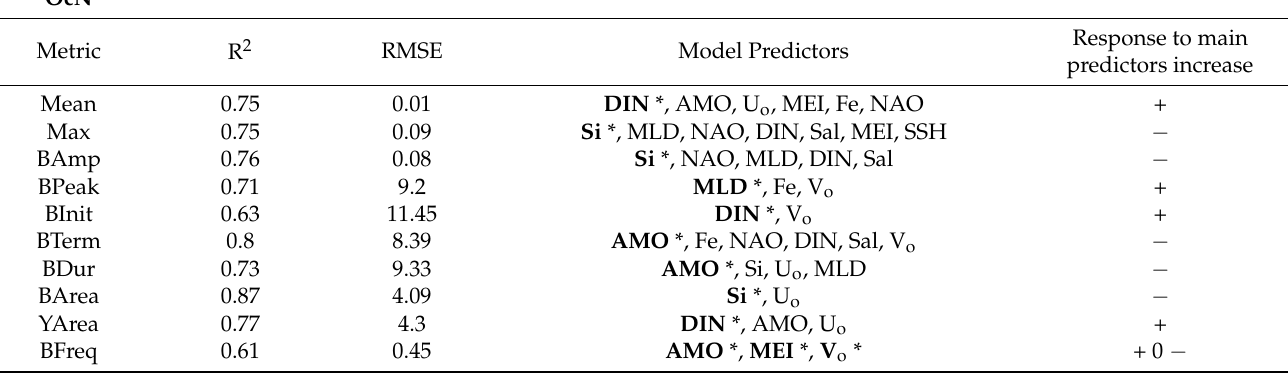
Table 4. Random forest models result for each phenoregion. For each phenology metric, the coefficient of determination (R 2 ), the root-mean-squared error (RMSE) and the predictors are presented in order of importance. The partial response of each metric to an increase in its main predictors (*) is also represented as plus (increase), minus (decrease) or 0 (neutral), following the order of the